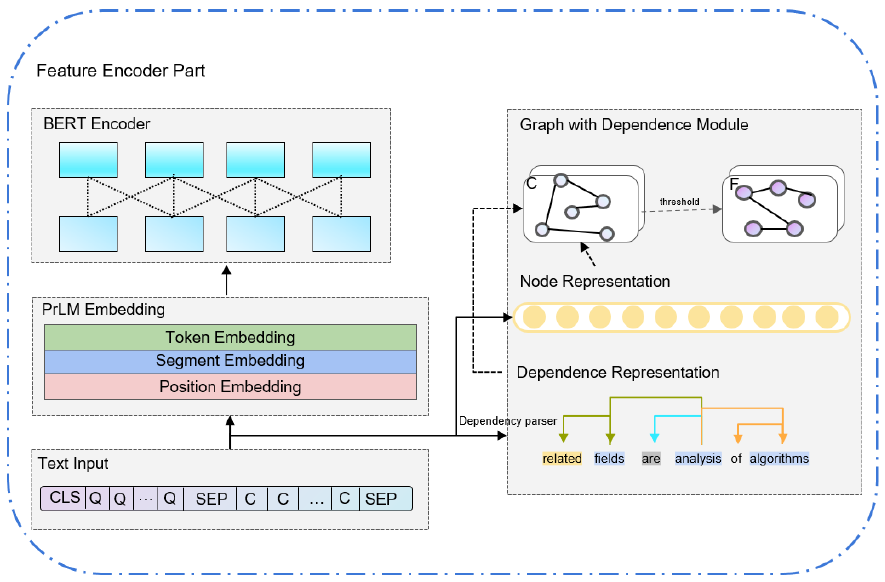
Figure 3. This is the overall structure of the feature encoder part. On the left side of the figure, PrLM applies special delimiters ((CLS) and (SEP)) to text sequences. On the right side of the figure, the GD module extracts the dependencies and builds the graph